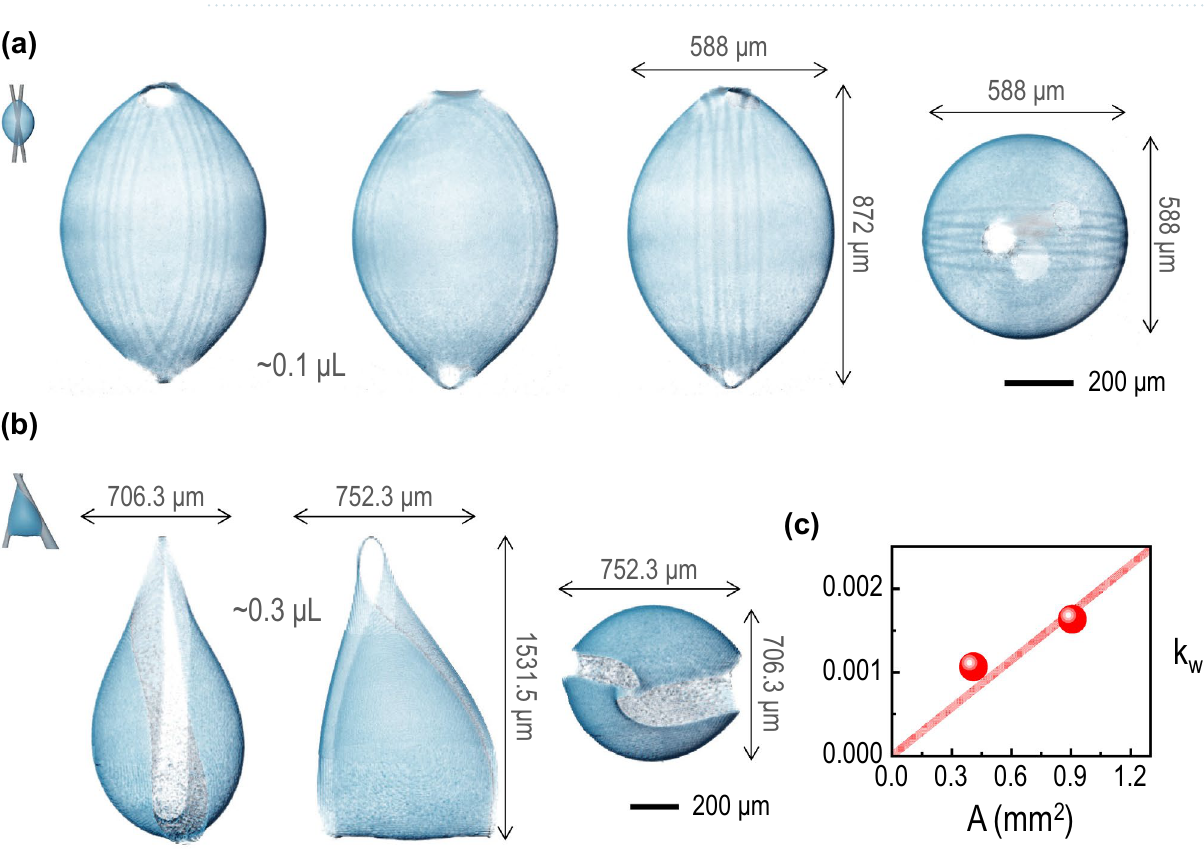
Figure 4. Two different irregular water droplets on glass wires, taken by 4D X-ray microtomography, ( a ) for the initial 0.1 µ L water droplet (the crossing angle of the wires is 22.07 (the crossing angle of the wires is 36.84 in the inset of Fig. 3 and the contact surface areas A [mm proportionality, as described by the trend line as k w = 0.0019 A ( R